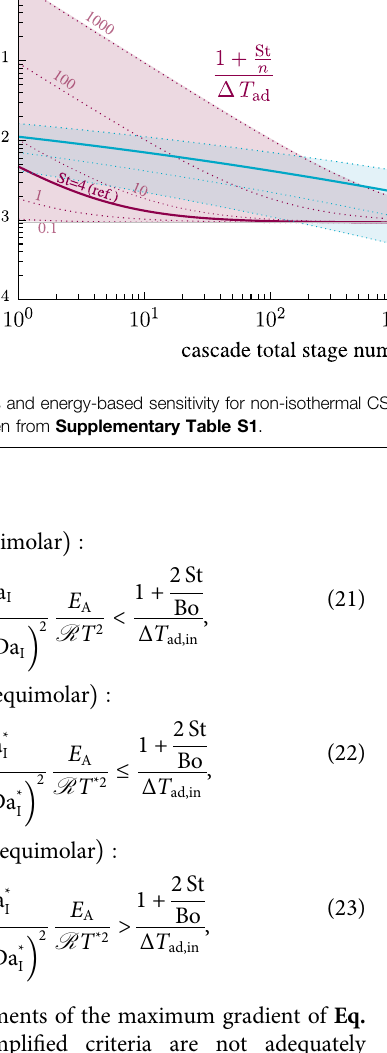
Frontiers in Energy Research |